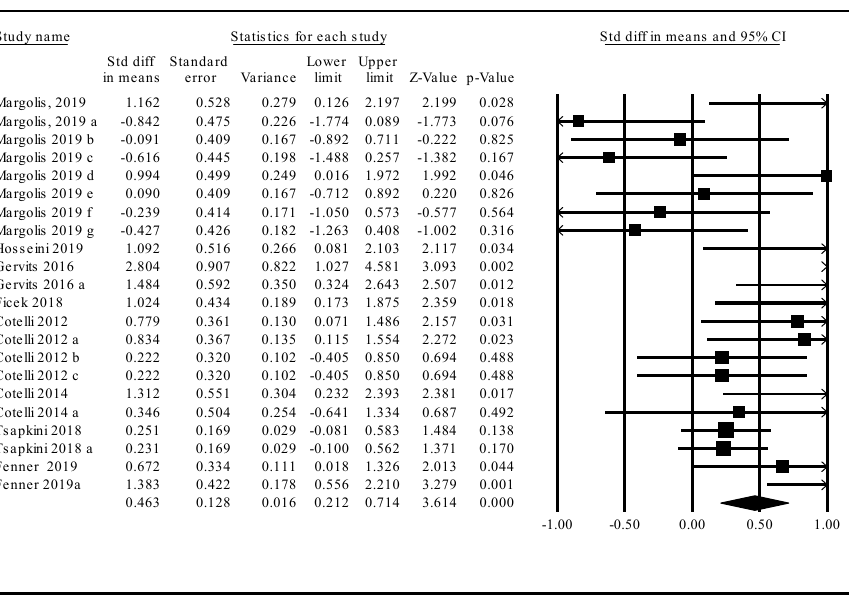
Figure 2. Overall meta-analysis effect sizes of transcranial direct current stimulation (tDCS) and transcranial magnetic stimulation (TMS) treatment studies in primary progressive aphasia (PPA). Corresponding forest plots demonstrate the overall treatment effects (<0 favors sham; >0 favors active stimulation).